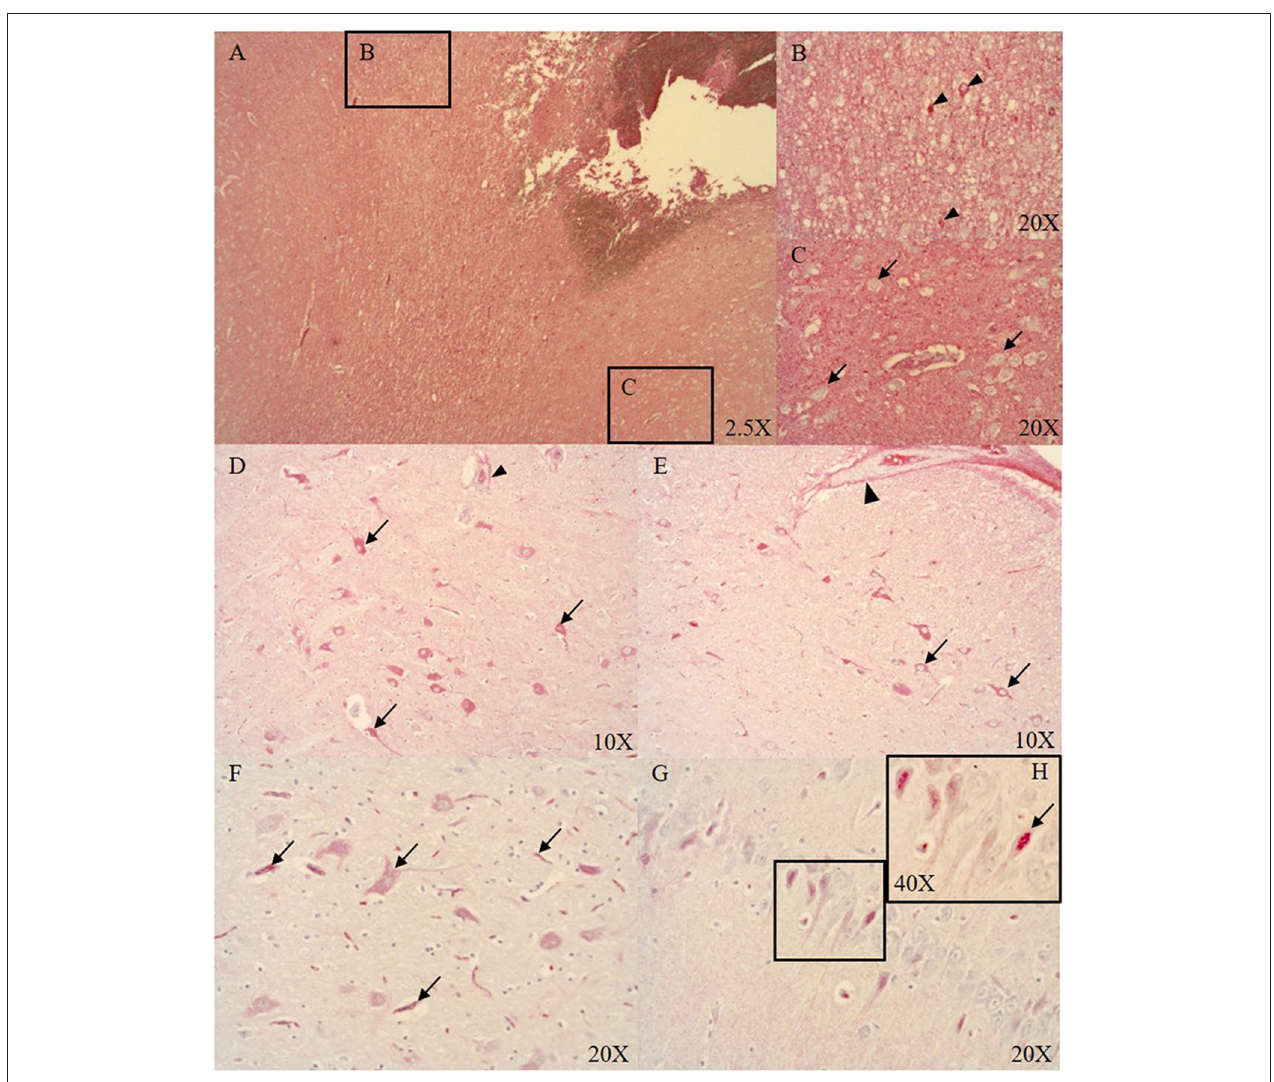
FIGURE 2 | Alb expression in the ipsi- ( A–C , midbrain cortical region) and contralateral ( D–G , midbrain subcortical region) side ( n = 9). Alb expression at the ASDH site (ipsilateral): extensive Alb extravasation (A) , singular neurons around the ASDH site are positive for Alb (black arrow heads B ), most cortical neurons were negative for Alb (black arrows C ). Alb expression in the contralateral hemisphere (distant to the ASDH site): minor Alb extravasation from microvasculature (indicated by positive adventitia of microvasculature (arrow head) and parenchyma), cytoplasmic positive neurons around vacuolization (black arrows D ), pial artery SMCs negative, positive adventitia (arrow head), positive neurons associated with swelling (black arrows E ), Alb contained in neurons and inside the microvasculature (black arrows F ), hippocampal neurons show nuclear Alb expression (G) magnified in (H) , see black arrow. ASDH, acute subdural hematoma; Alb, albumin; SMCs, smooth muscle